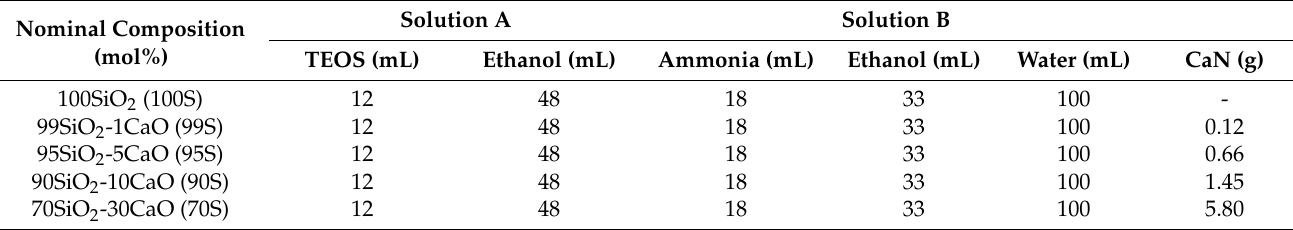
Figure 1. Schematic illustration of the synthesis route for bioactive glass nanoparticles (BGNs). Table 1. Nominal composition of BGNs with various CaO concentrations and their corresponding synthesis recipe. TEOS: tetraethyl orthosilicate; CaN: calcium nitrate tetrahydrate.